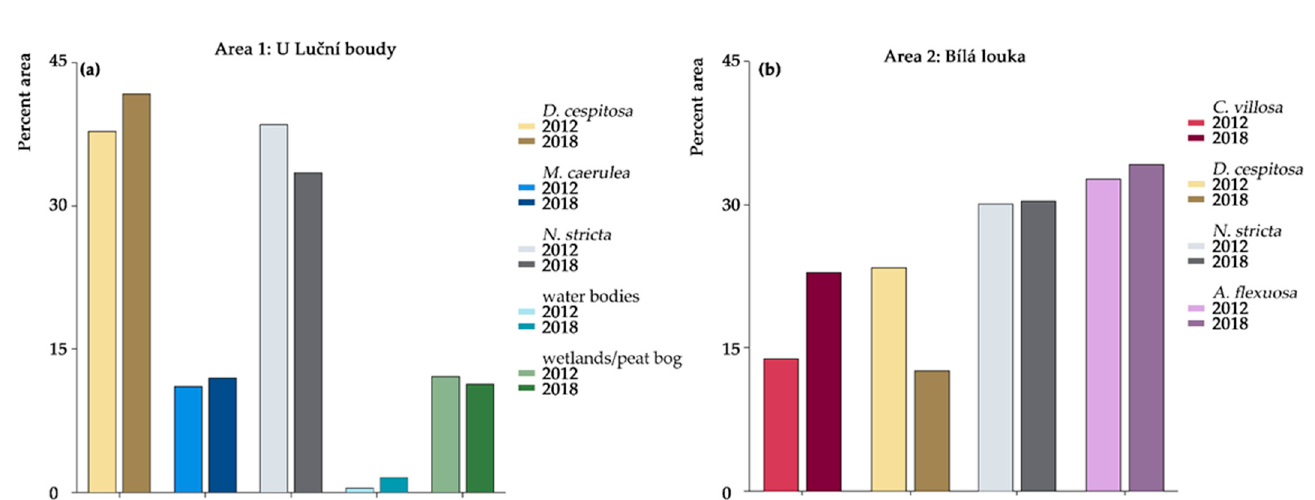
Figure 1. Relative area of the species in both studied areas in 2012 and 2018 based on the maximum likelihood classification of RGB orthophotos with a 25 cm pixel. Area 1: U Lu č ní boudy ( a ); Area 2: Bílá louka ( b ).